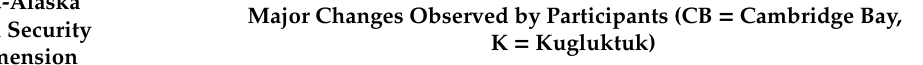
Table 1. Summary of food security related changes observed by